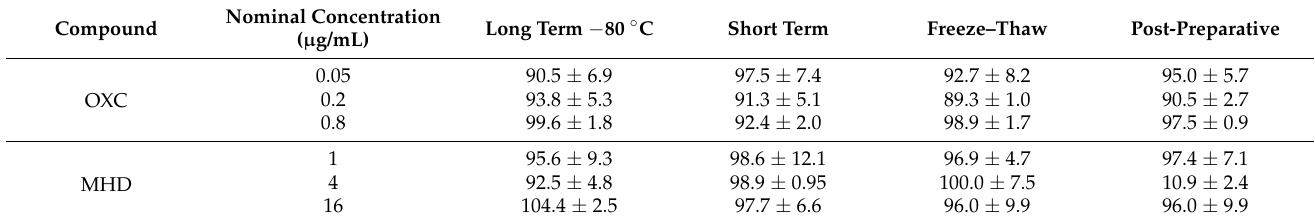
Table 3. Stability of oxcarbazepine (OXC) and 10-hydroxycarbazepine (MHD) under various storage conditions (data are mean ± SD, %, n =